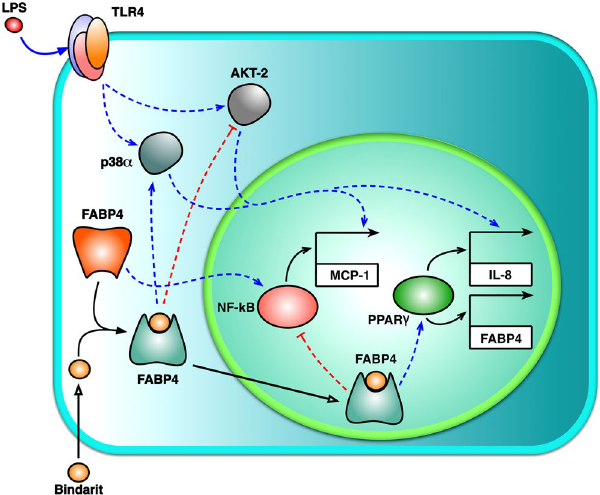
Figure 6. Proposed model for bindarit action. The potential mechanism of action of bindarit is presented. See text for